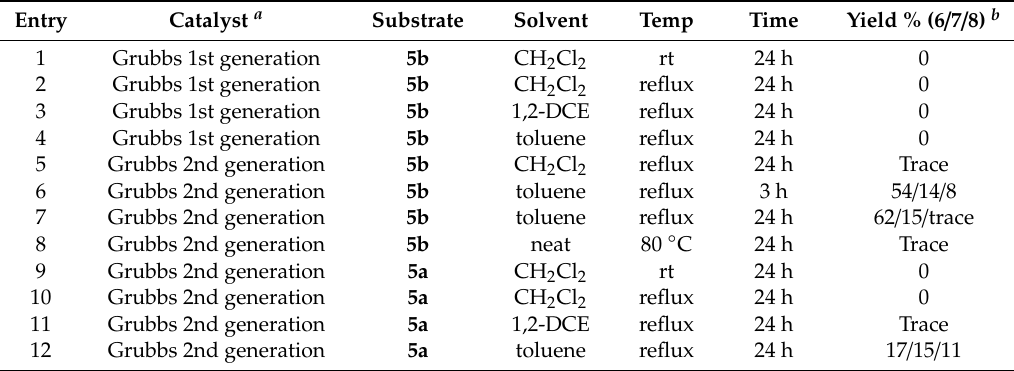
Table 1. Screening of reaction conditions for cross metathesis between 4 and 5 .